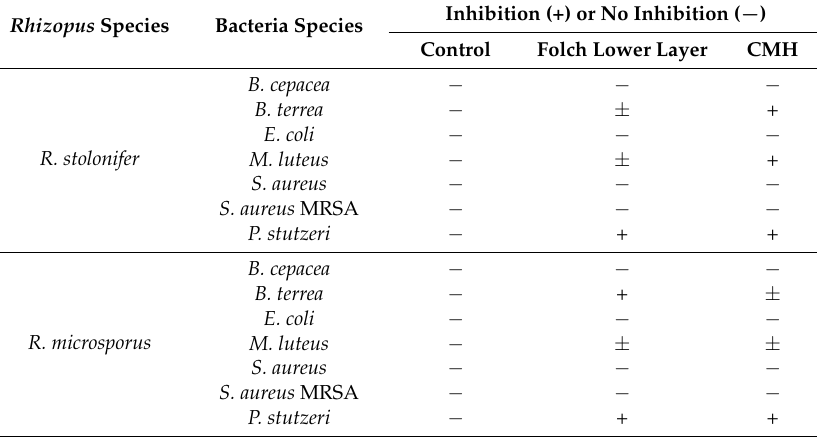
Table 1. Antimicrobial Activity of CMHs from Rhizopus species by Agar Diffusion Assay. Lipid samples (Folch lower layer and CMH) from R. stolonifer and R. microsporus grown in PDB were dissolved in chloroform/methanol (2:1 v / v ) at a concentration of 50 mg/mL (10 µ L). The negative control consisted of 10 µ L of chloroform/methanol (2:1 v / v